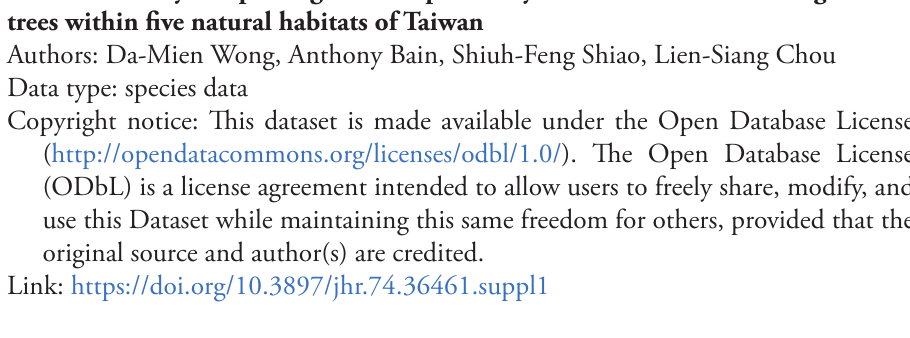
Table S1. Thirty sampled figs were haphazardly collected from Ficus benguetensis trees within five natural habitats of Taiwan